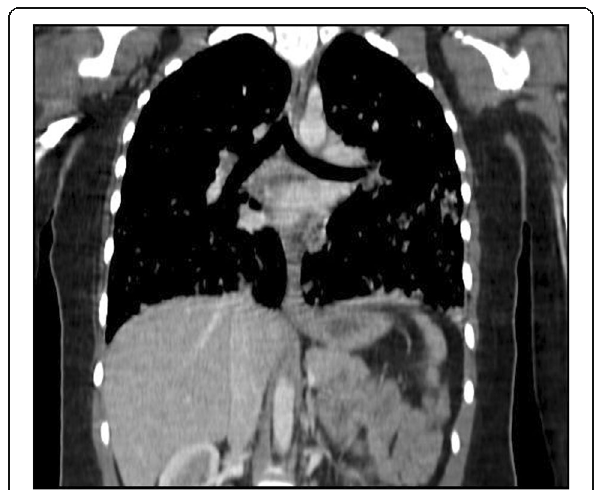
Fig. 5 Coronal reconstruction of chest computed tomography in a mediastinal window demonstrating a weak filling defect in the right lower lobe pulmonary